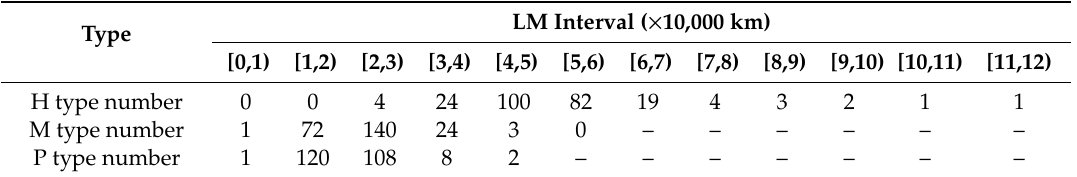
Table 1. The number of three types for PCCS in the LM interval.